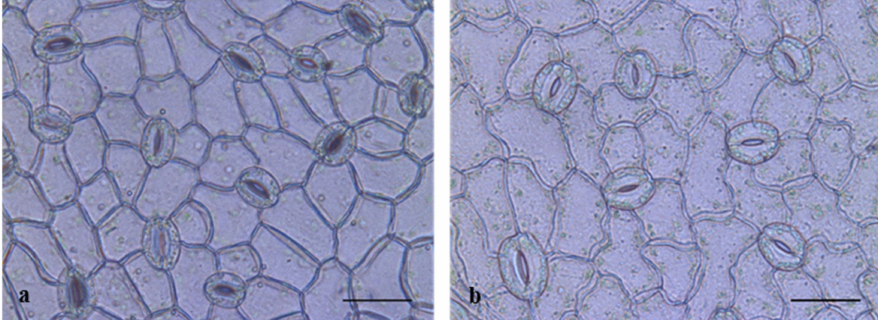
Figure 10. Stomatal characters of diploid and triploid plants. ( a ) Diploid, ( b ) triploid; scale bar = 20 µ